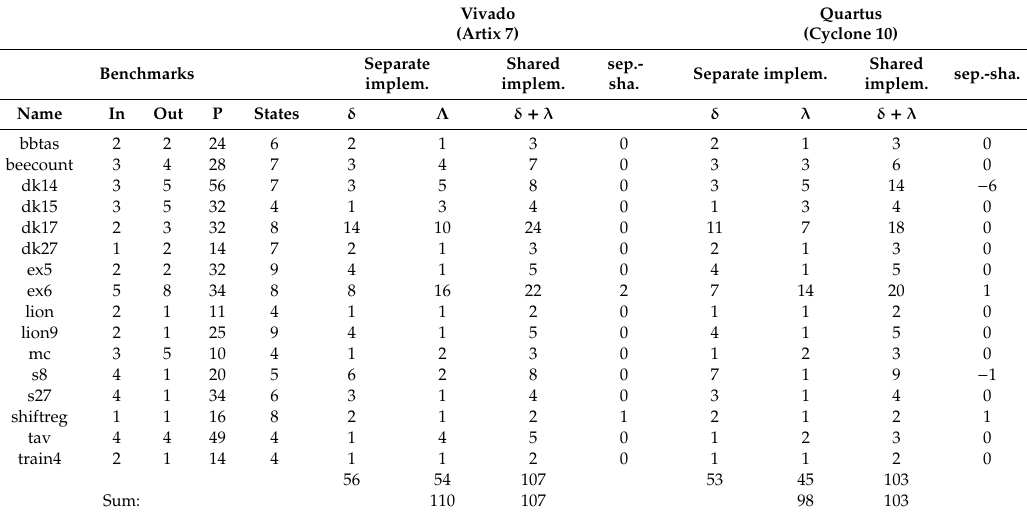
Table 5. Results of experiments (Vivado and Quartus II, number of states < 10). Benchmarks